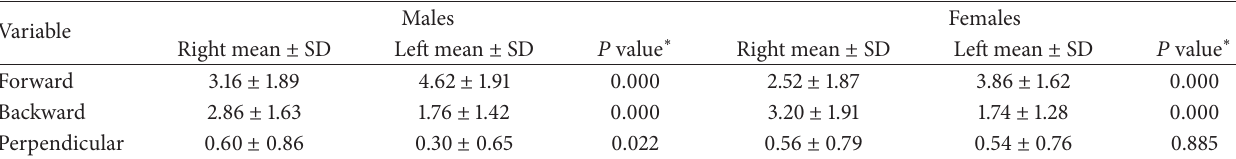
Table 6: Bilateral differences (left-right) in rugae directions in both